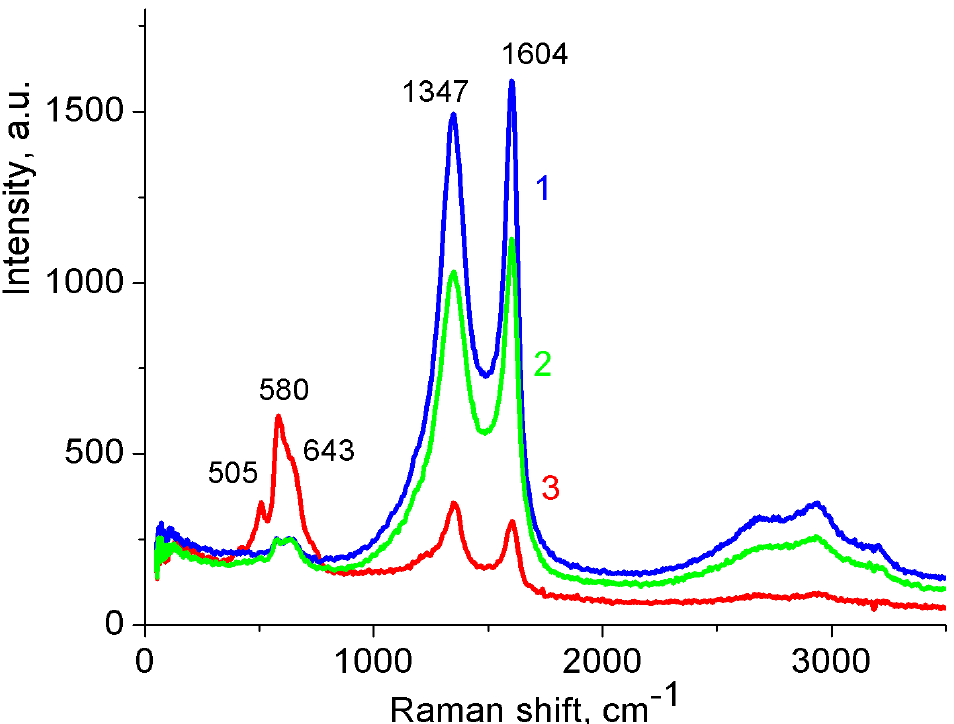
Figure 2. Raman spectra of MnO 2 /MWCNT/Al samples obtained under various conditions. Duration of treatment in KMnO 4 solution 90 min. Concentration of KMnO 4 solution, wt.%: 1: 0.2; 2: 1; 3: 2.